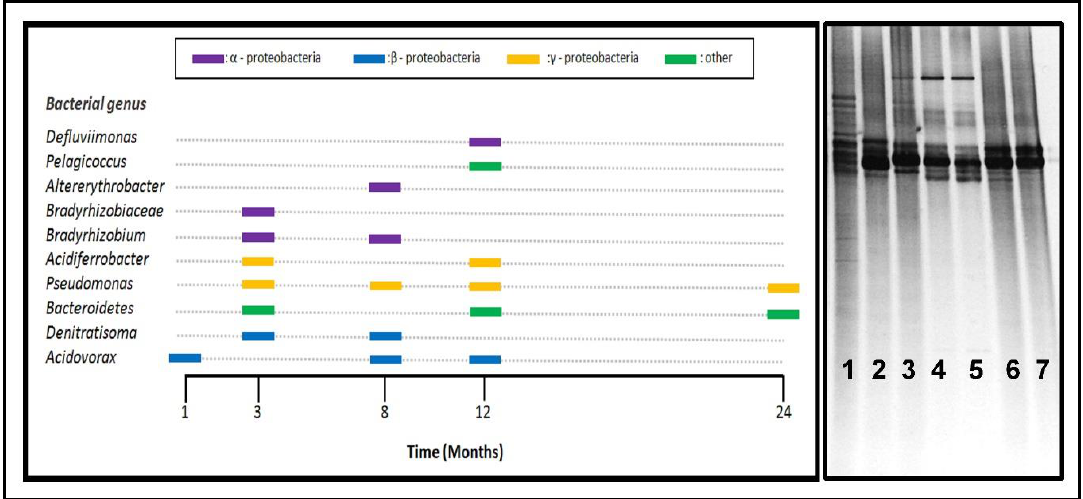
Figure 4. (Left) Diagram showing the distribution of bacterial phylotypes over time. (Right) Denaturing gradient gel electrophoresis (DGGE) profile of 16S rRNA of total bacterial community from bulk (line 1) and biofilm from inner copper pipes (line 2:1 month; lines 3 and 4:3 months; line 5:8 months; line 6:12 months; and line 7:24 months).